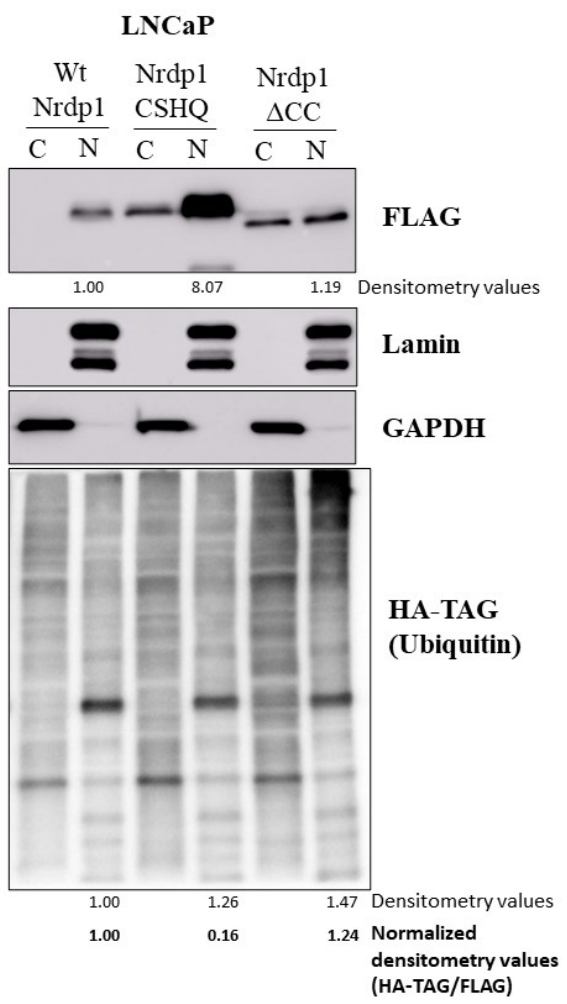
Figure 7. NRDP1 can act as a ubiquitin ligase within the nucleus of prostate cancer cells. Co-transfection of LNCaP with the Wt, CSHQ, or Δ CC NRDP1 constructs with an HA-tagged ubiquitin construct (HA-TAG)(3 ug per 100 mm dish, 72 h) followed by subcellular fractionation and western analyses confirmed that NRDP1 retains its ability to function as a ubiquitin ligase when located in the nucleus; transfection with Δ CC, which retains its ability to ubiquitinate target proteins, caused a 1.24-fold increase in levels of ubiquitinated nuclear proteins compared to Wt NRDP1 (HA-Ub densitometry scores were normalized based on NRDP1-FLAG expression, higher levels of Δ CC NRDP1 were expressed compared to Wt NRDP1 since Δ CC cannot mediate oligomerization/degradation of NRDP1 by auto-ubiquitination). Transfection with CSHQ, caused a 5-fold decrease in levels of ubiquitinated nuclear proteins compared to Wt NRDP1, this is expected as the CSHQ construct cannot ubiquitinate target proteins and would compete with endogenous NRDP1 for target binding. Detailed information about Western Blot can be found at supplementary materials.